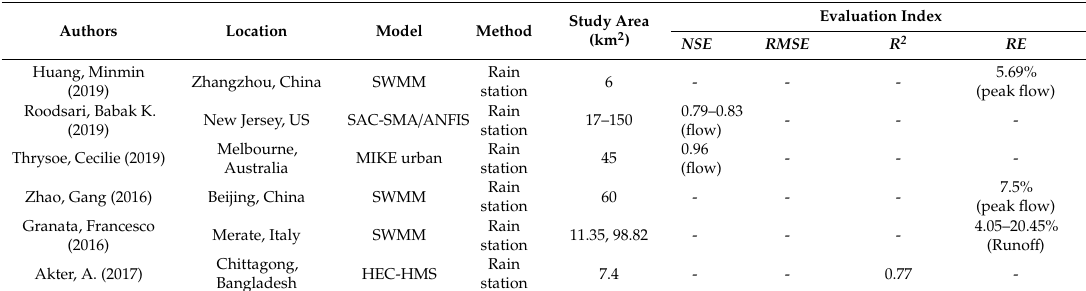
Table 5. Traditional technology rain test statistics table